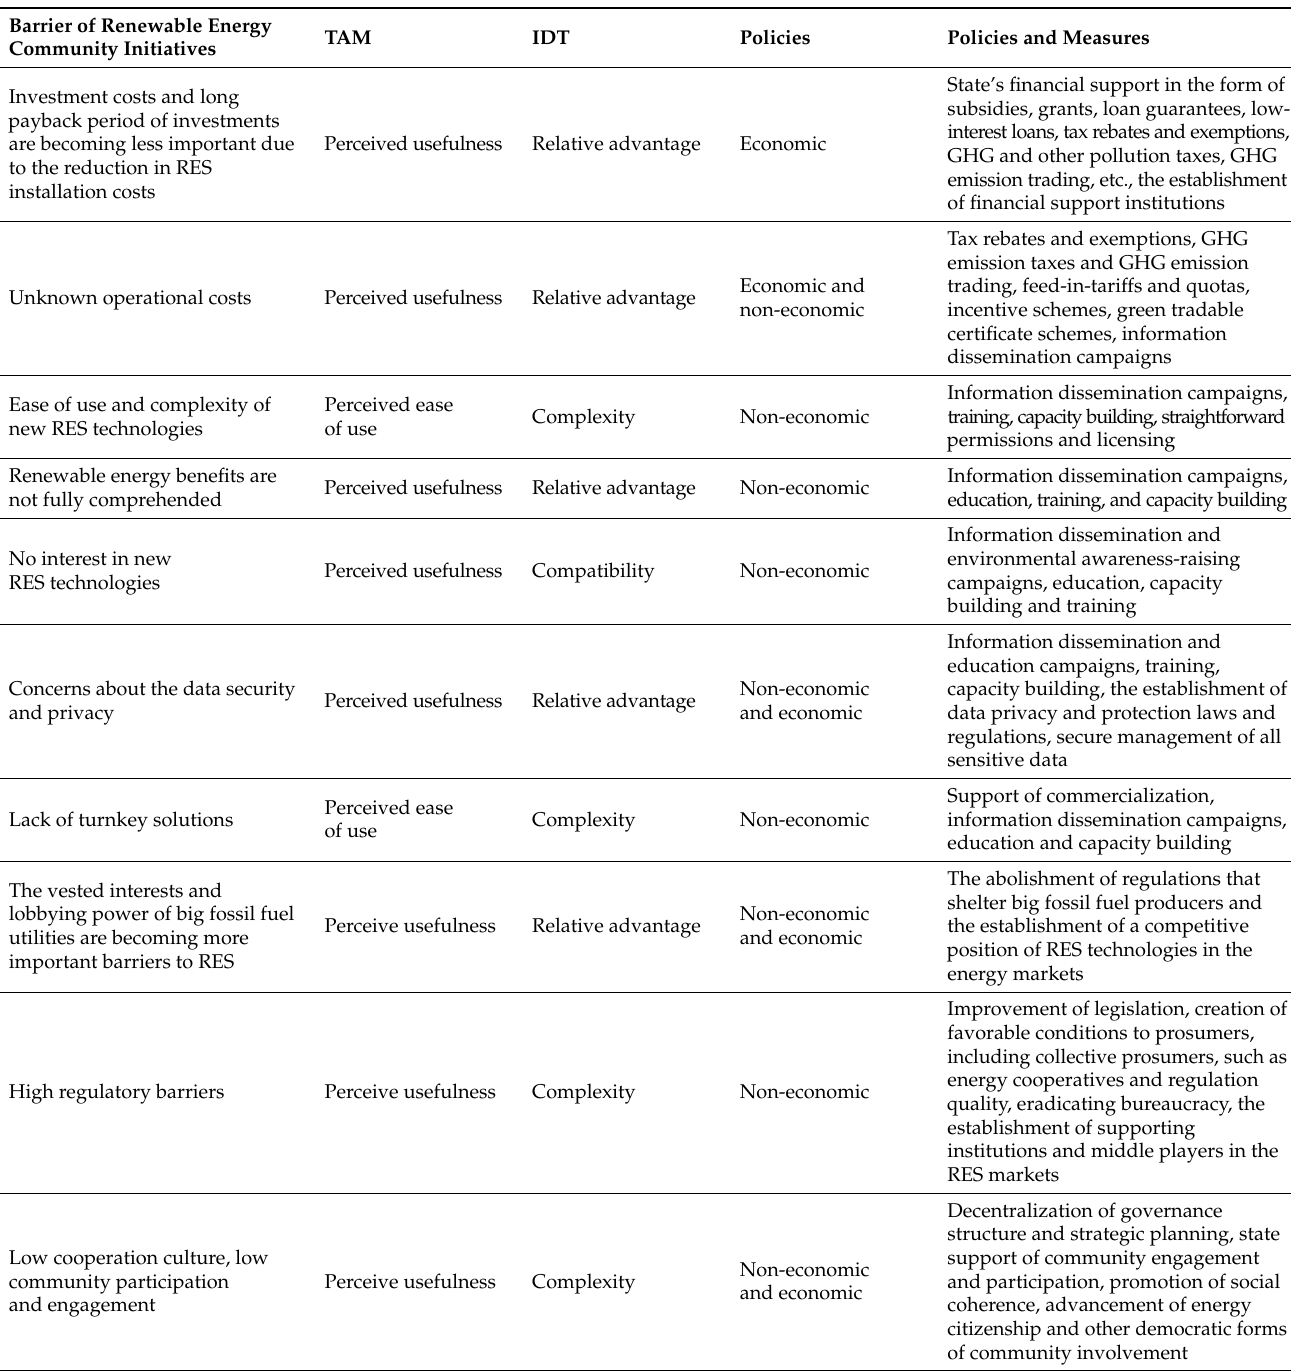
Table 2. Policies and measures to overcome renewable energy initiatives in rural areas and their linkages with the main technology adoption